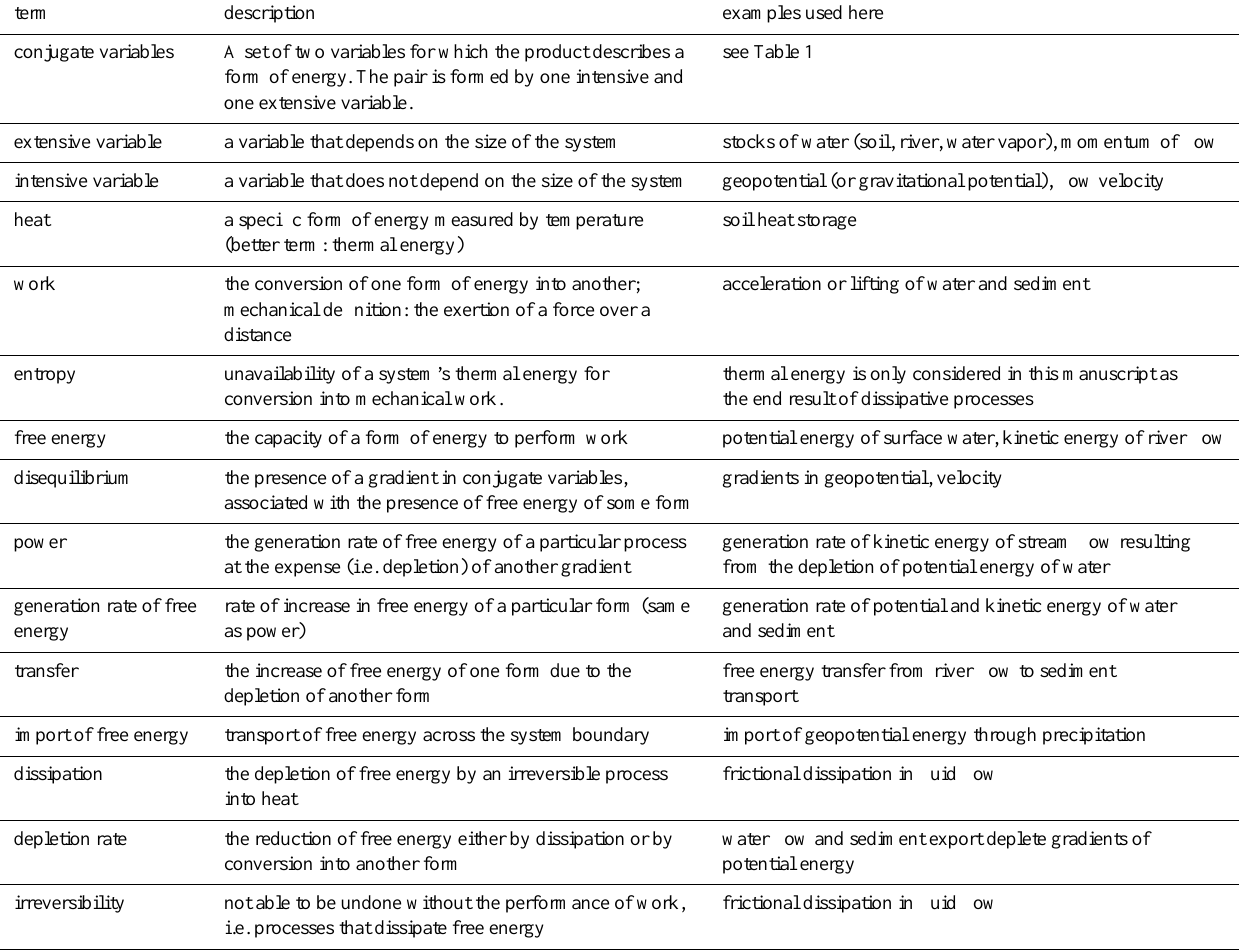
Table 2. Overview of the different thermodynamic terms used here, their brief definitions and their relevance to hydrologic processes. term description examples used